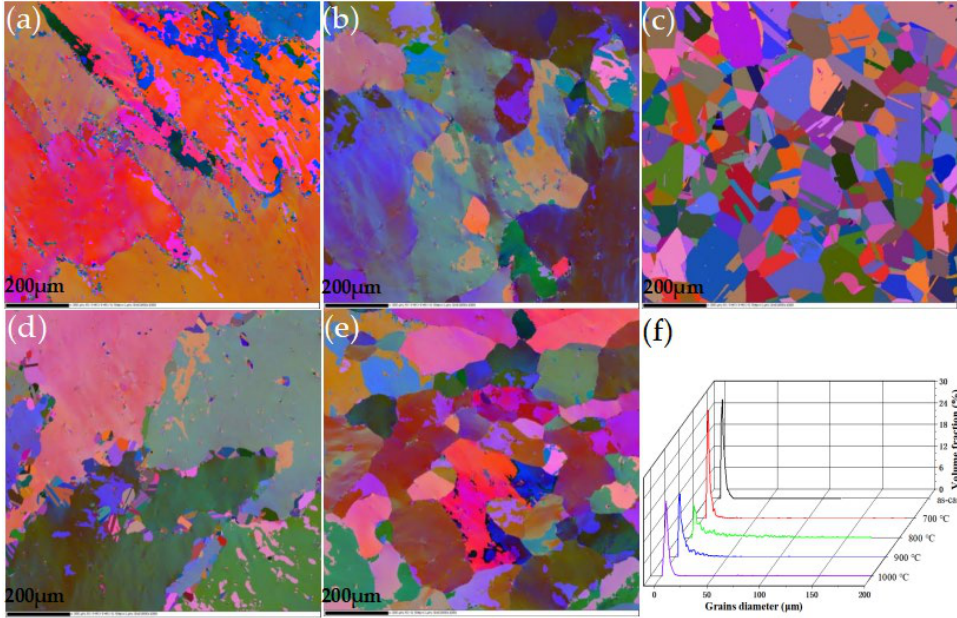
Figure 4. EBSD patterns of (FeNi)67Cr15Mn10Al5Ti3 HEA: ( a ) as-cast; ( b ) 700 °C; (c ) 800 °C; ( d ) 900 °C; ( e ) 1000 °C; ( f ) grain size distributions.